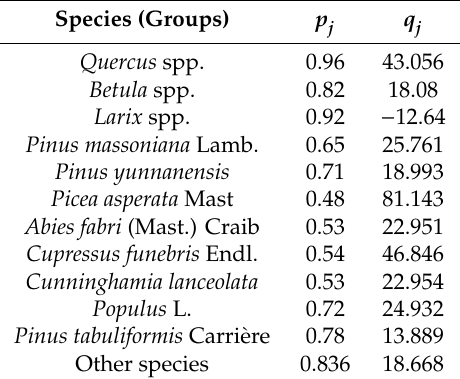
Table A2. The Forest Stock—forest biomass conversion relationship model coe ffi cients.